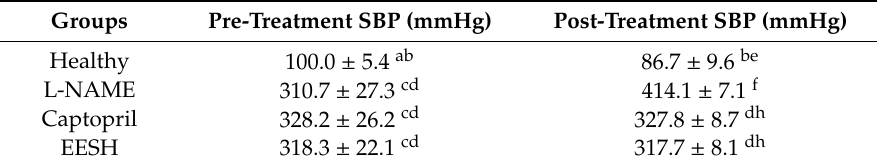
Table 1. Systolic blood pressure in Wistar